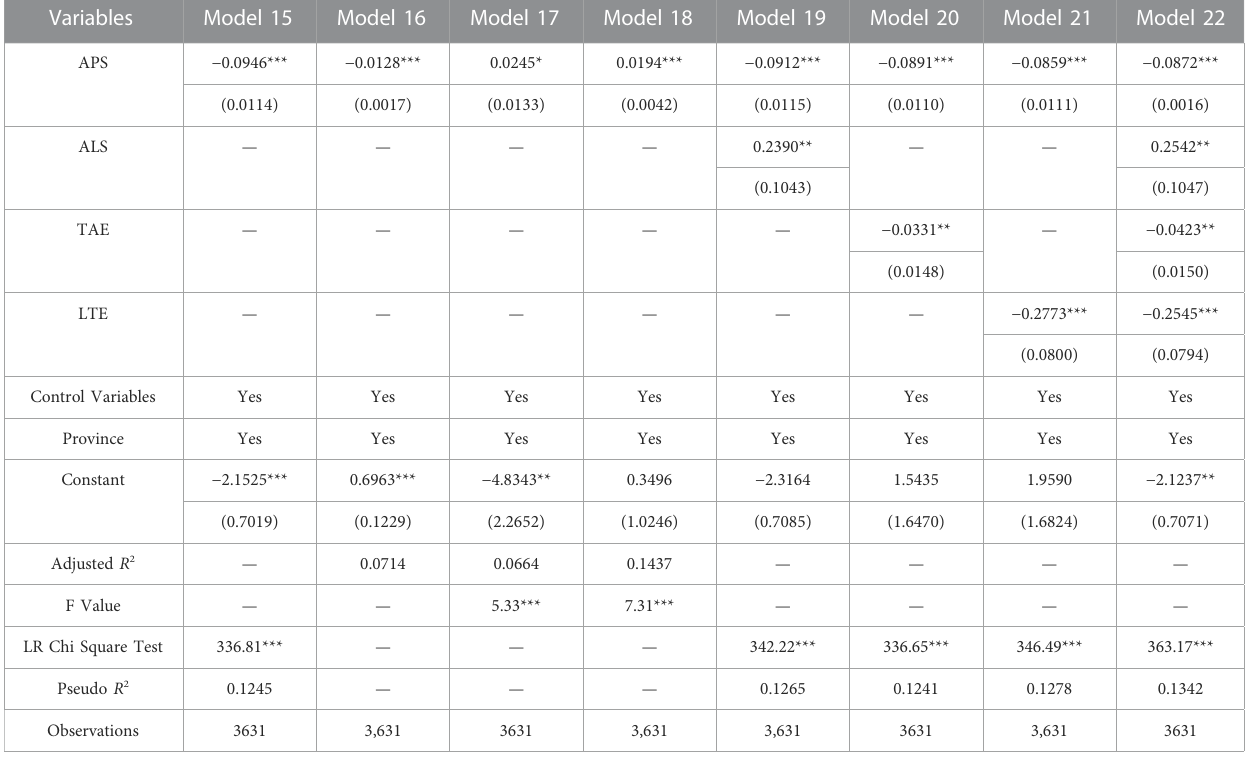
TABLE 4 Estimated results of the impact mechanism of APS on land abandonment.